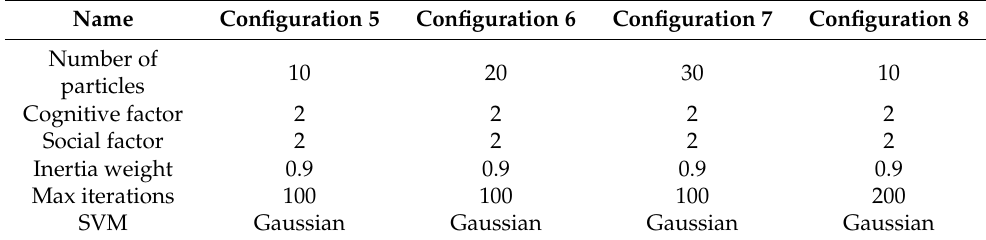
Table 16. Initial parameters used for the PSO for experiments with Gaussian